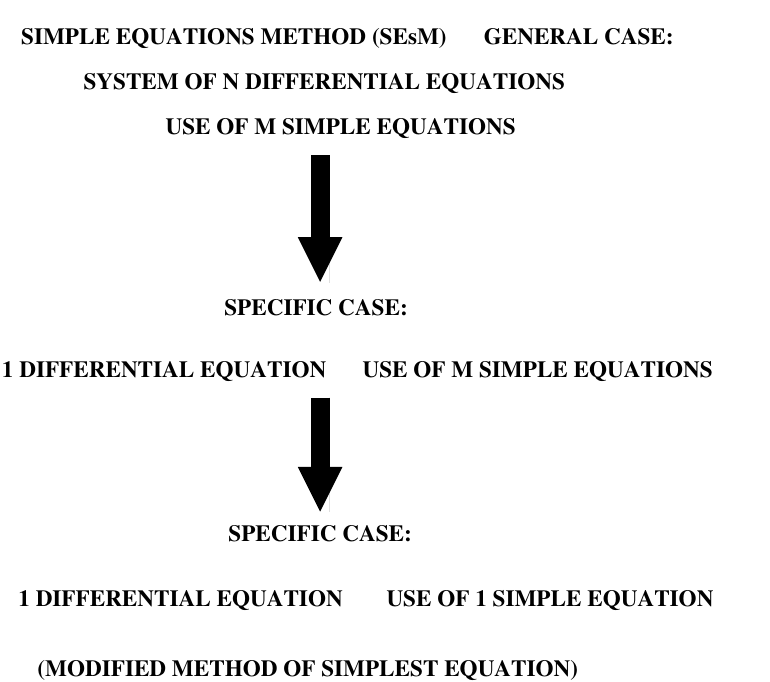
Figure 1. The general case of the simple equations method and two of its specific cases. The general case of the SEsM is to search for the solution of a system of N differential equations. The solution is constructed on the basis of the solutions of M simpler differential equations (the parameter M may depend on the parameter N ). A specific case of the SEsM is the case when one has to solve one differential equation and the solution is constructed on the basis of the solutions of M simpler differential equations. The simplest case of the SEsM is as follows. One has to solve one differential equation. The solution is constructed by the solution of one simple equation. This specific case is known as the modified method of simplest